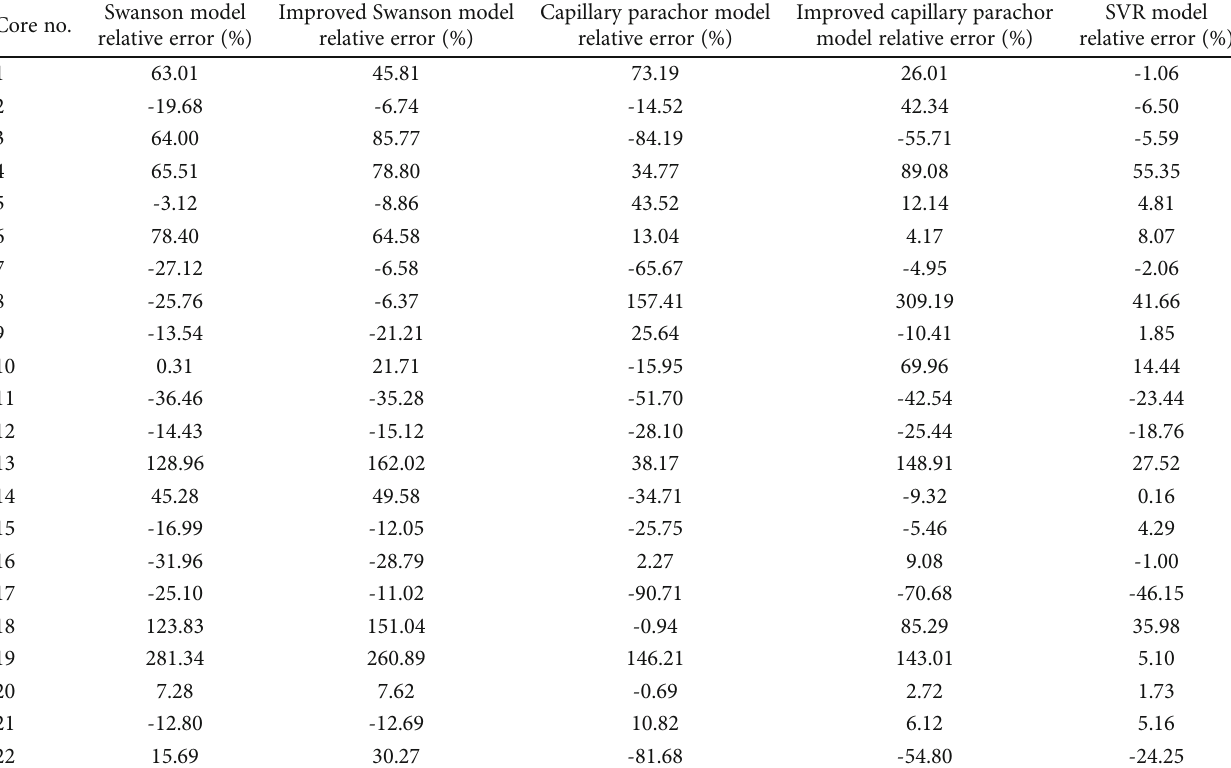
Table 4: Relative error analysis of the predicted permeability of the fi ve types of models. Core